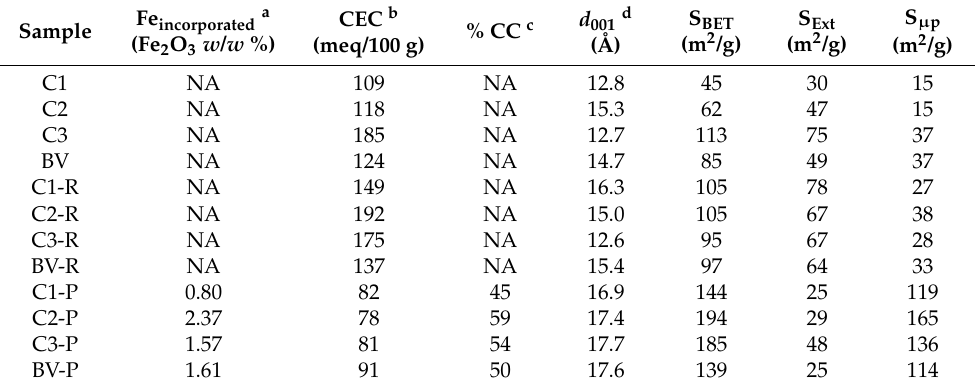
Table 3. Iron incorporated, CEC, compensated fraction of CEC (CC), basal spacing and textural properties of raw, refined, and Al/Fe-pillared